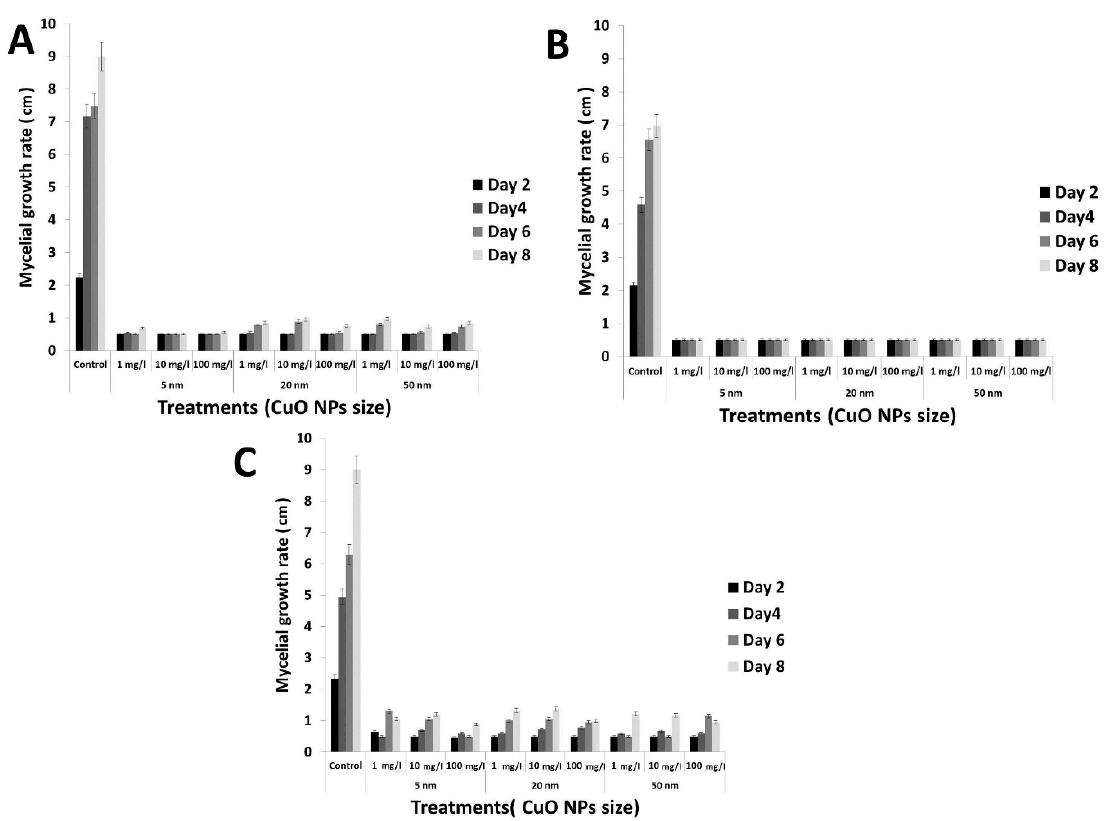
Figure 3. Antifungal activity of rGO-CuO NPs against F. oxysporum strains. Plot of fungal growth rate versus CuO NP size and rGO-CuO NP concentration at different time points, as indicated, for FOR) ( A ), FOC1 ( B ), and FOC2 ( C ).